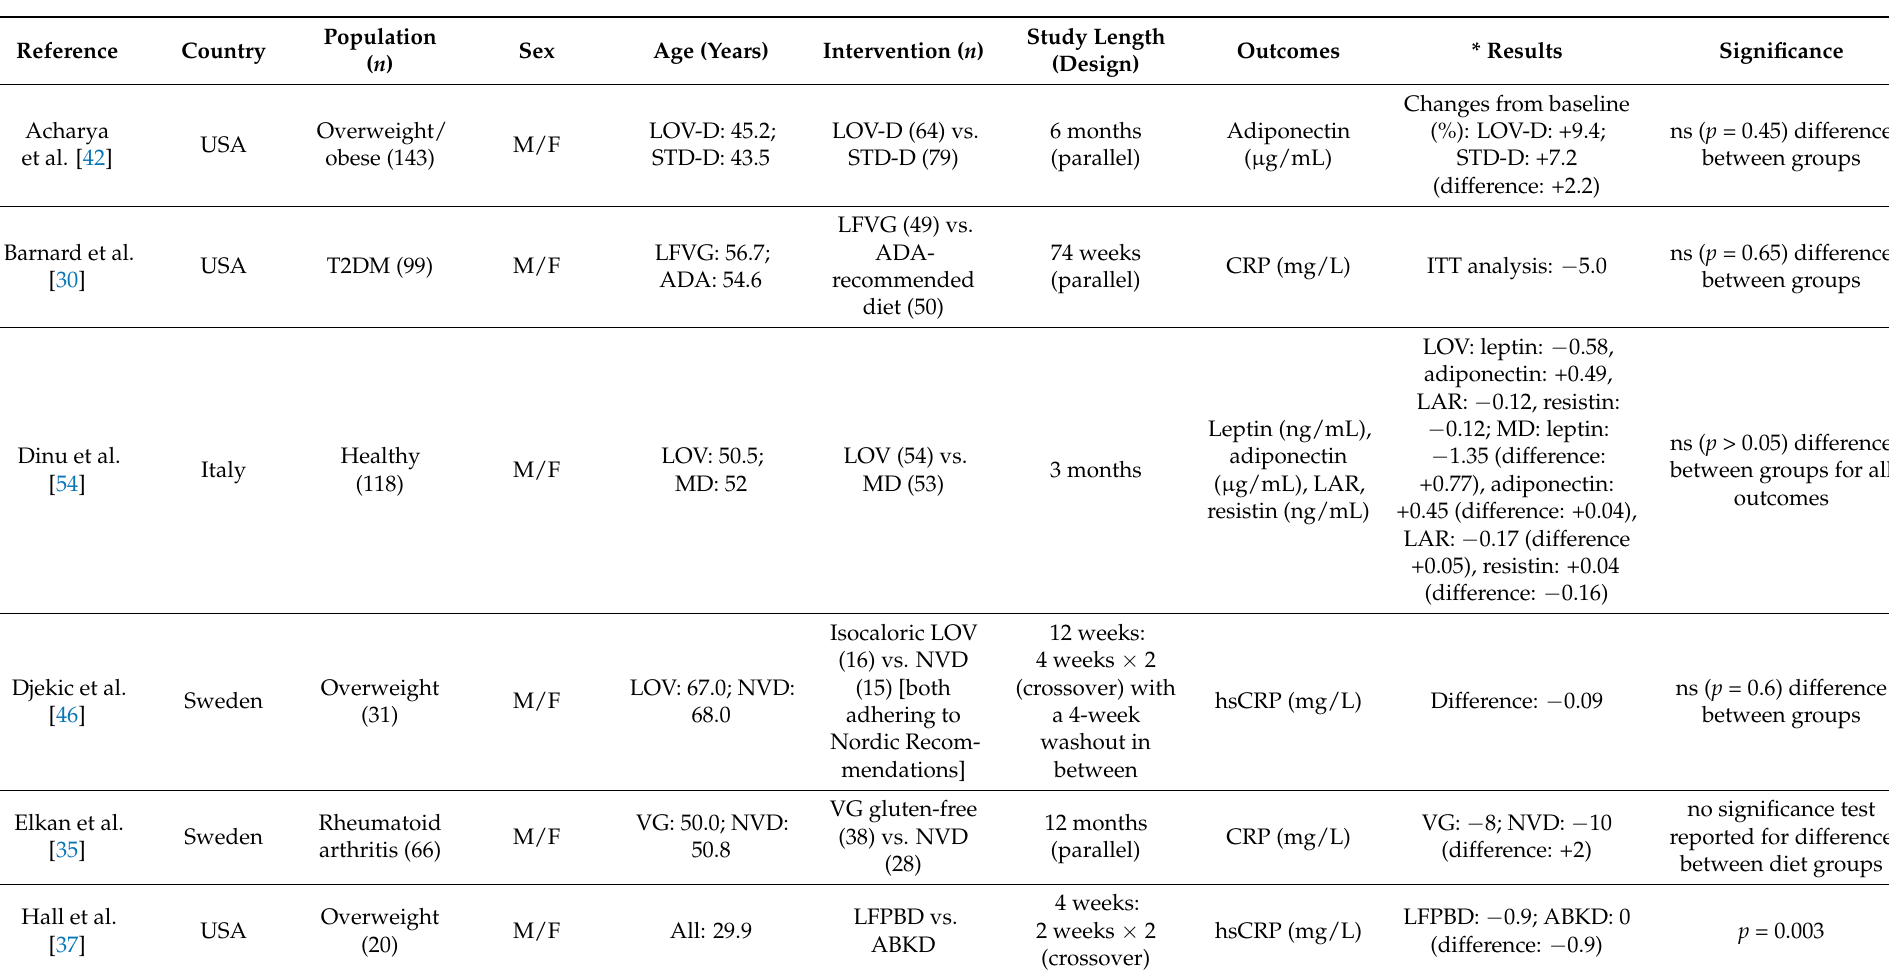
Table 6. Randomised Controlled Trials of Plant-Based Diets and Inflammatory